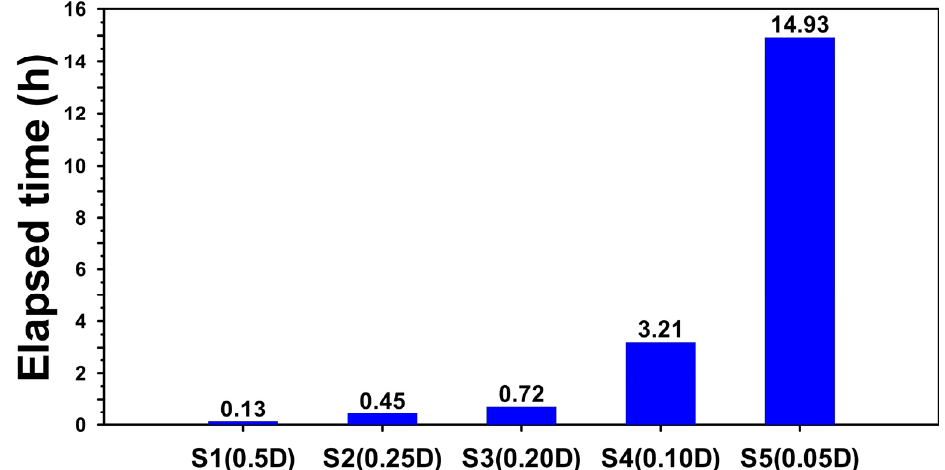
Figure 13. Elapsed time of a 29-day simulation using five model grid resolutions.